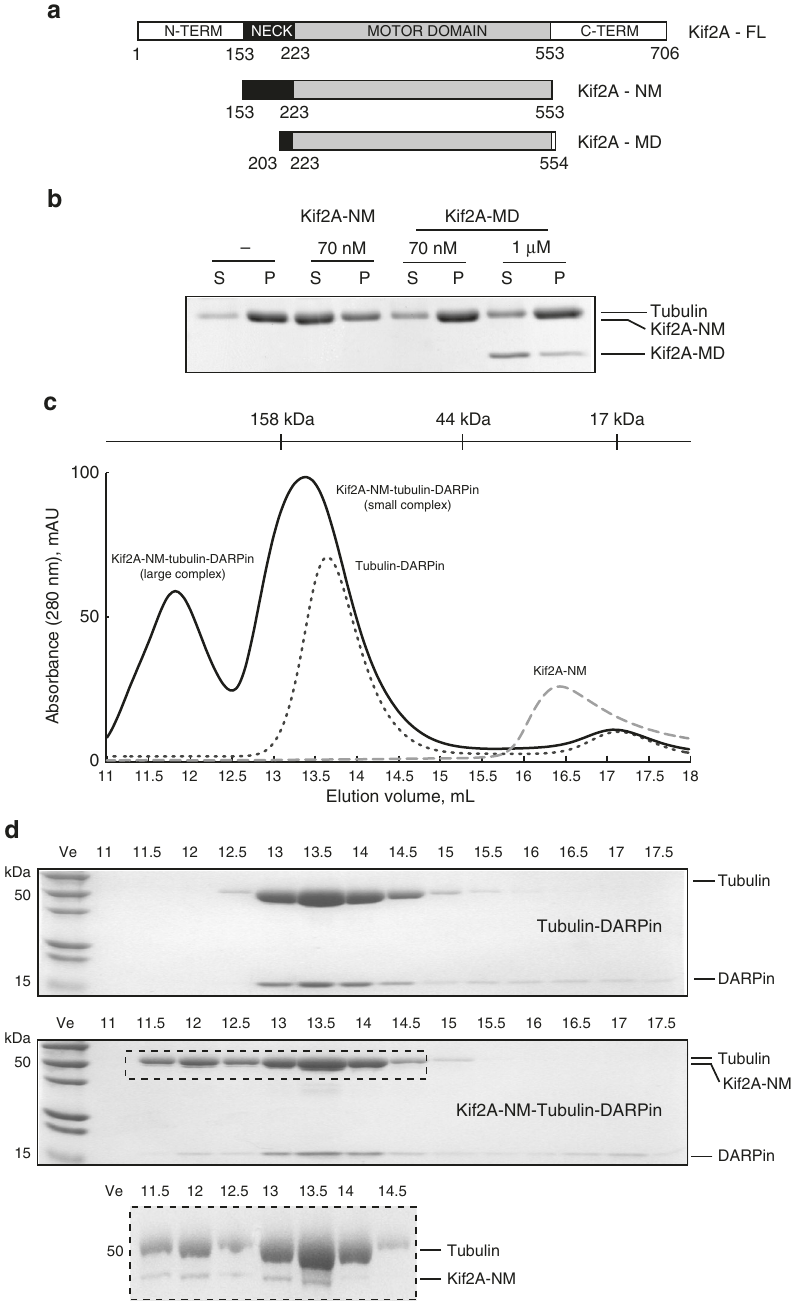
Fig. 1 Functional analysis of Kif2A constructs. a Domain composition of human Kif2A and schematic of the Kif2A constructs used in this study. The length of the bar is proportional to the number of amino acids. b MT depolymerization activity of Kif2A constructs. Taxol-stabilized MTs were incubated with the indicated concentrations of Kif2A-NM and Kif2A-MD, or no kinesin for 10 min in BRB80 buffer. Free tubulin and MT polymers were separated into supernatant (S) and pellet (P) fractions by ultra-centrifugation-based sedimentation assay. Fractions were resuspended and boiled in Laemmli buffer. Equal portions were loaded and analyzed on a Coomassie blue-stained SDS-PAGE gel. c SEC pro fi les of Kif2A-NM alone (gray dashed line), tubulin – DARPin complex (black dotted line), and Kif2A-NM – tubulin – DARPin complex in 0.8:1:1 molar ratio (black solid line). All samples were supplemented with 0.1 mM AMPPNP and applied to an Superdex 200 10/300 GL column in HEPES buffer. d Twelve percent SDS-PAGE gels of elution fractions from the above experiments. The molecular weight of Kif2A-NM = 48 kDa, tubulin = 50 kDa, and DARPin = 18 kDa. The inset shows a 10% SDS-PAGE gel of fractions containing the Kif2A-NM – tubulin – DARPin complex in order to visualize the Kif2A and tubulin proteins. All uncropped gels are shown in